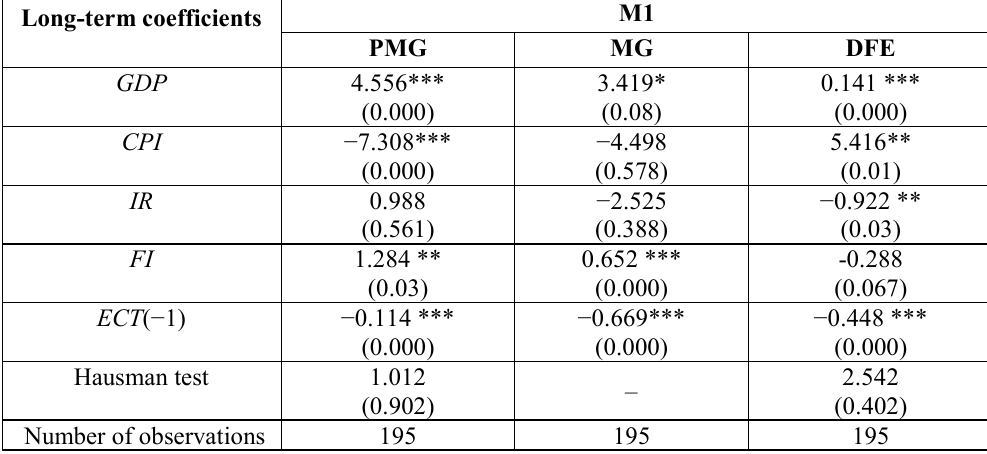
3.419* (0.08) − 4.498 (0.578) − 2.525 (0.388) 0.652 *** (0.000) − 0.669*** (0.000) –